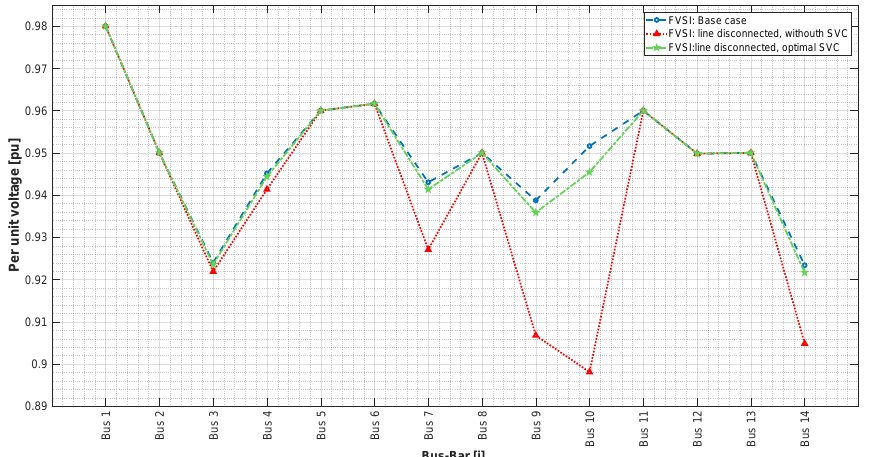
Figure 10. First study case: Voltage profiles before/after contingencies and with SVC compensation, when the line that contains the node for the optimal solution is